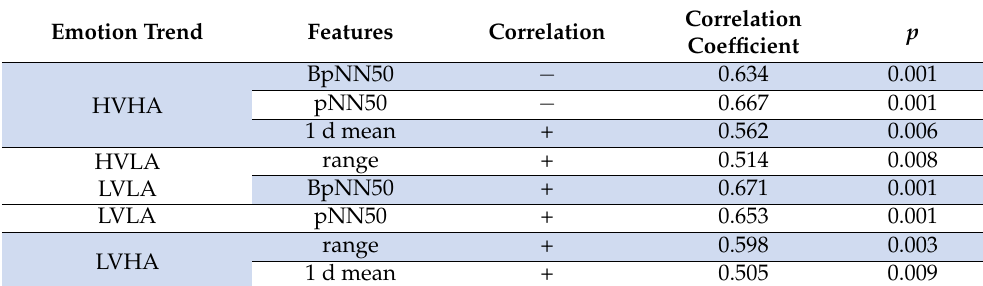
Table 6. The Pearson correlation